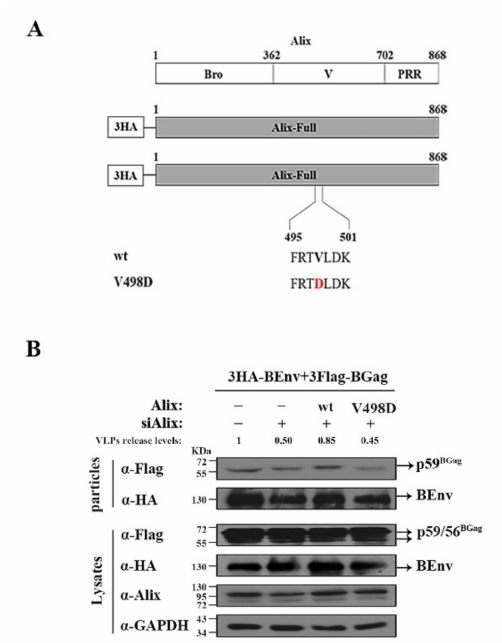
Figure 5. V498 in the V domain of Alix is crucial for BFV VLP budding. ( A ) Various forms of Alix (including full-length and the V498D mutant) were cloned into pCMV-3HA. The sequences of the indicated specific regions of wild-type and mutant Alix protein are shown. Amino acid altered in the mutant constructs is marked by red letters. ( B ) HEK293T (4 × 10 6 ) cells were transfected with siControl or siAlix 6 h before transfection with 3HA-BEnv, 3Flag-BGag (BFV Gag protein (BGag)), and either the pCMV-3HA or various forms of Alix vector constructs were then cultured for 24 h. The cell culture supernatants were filtered through a 0.45 µ m filter and purified by ultracentrifugation. Transfected cells were disrupted using lysis buffer. Levels of proteins in cells and supernatants were measured using Western